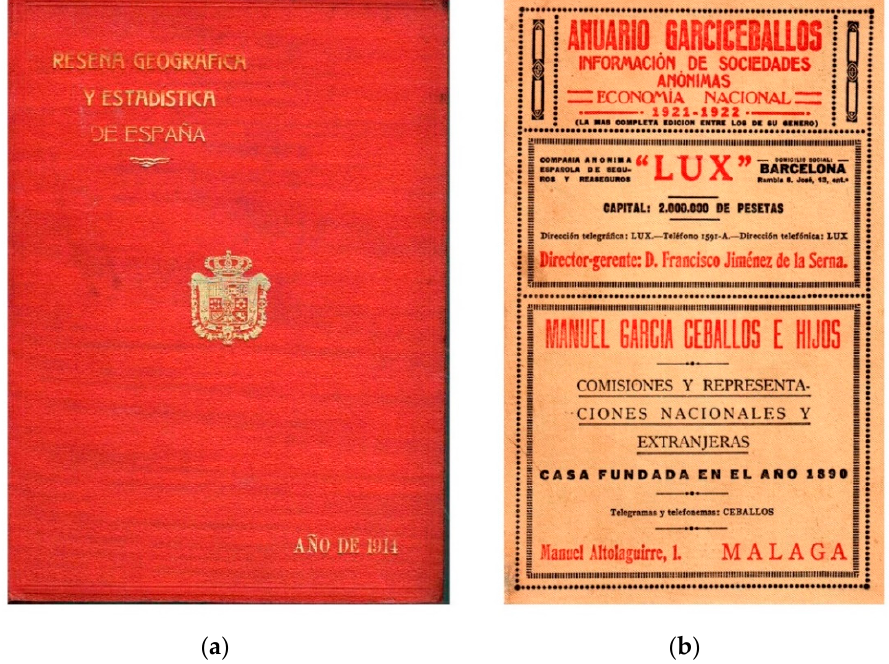
Figure 1. ( a ) Reseña Geográfica y Estadística de España (1914); ( b ) Anuario de Sociedades Anónimas García Ceballos (1921–1922).